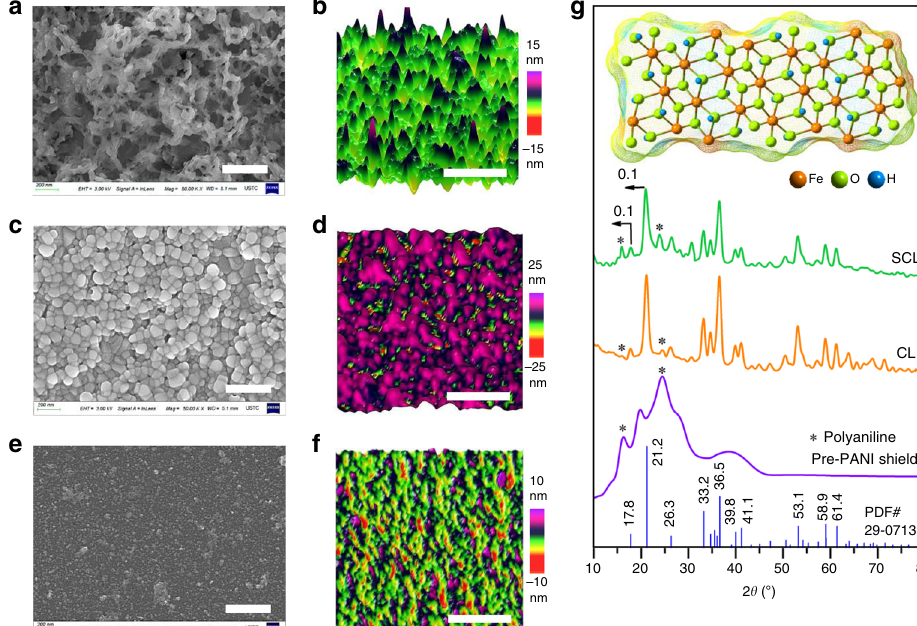
Fig. 2 Physico-crystallinity analysis of the in-situ produced SCL. a , c , e SEM micrographs showing the grown pre-PANI nanostructures as a porous networked web at the Na fi on-CEL surface, the produced Fe + 3 O(OH) catalyst nanoparticles and the post-PANI shield at the catalyst, respectively. b , d , f The AFM images in tapping mode at the three consecutive steps as a , c , e visualising the topographic features such as surface pits in the pre-PANI web, produced Fe + 3 O(OH) catalyst nanoparticles within the pits and the porous post-PANI shield. g Standard indexed peaks of the PDF#29-0713 card number for goethite Fe + 3 O(OH) material, XRD spectra of the pre-PANI shield, catalytic layer (CL) at pre-PANI and the shielded catalytic layer under post- PANI shield (SCL). Inset indicating a fully interconnected structure of goethite Fe + 3 O(OH) material. The scale bars in a , c , e correspond to 400 nm, whereas the scale bars in b , d , f are equal to 200